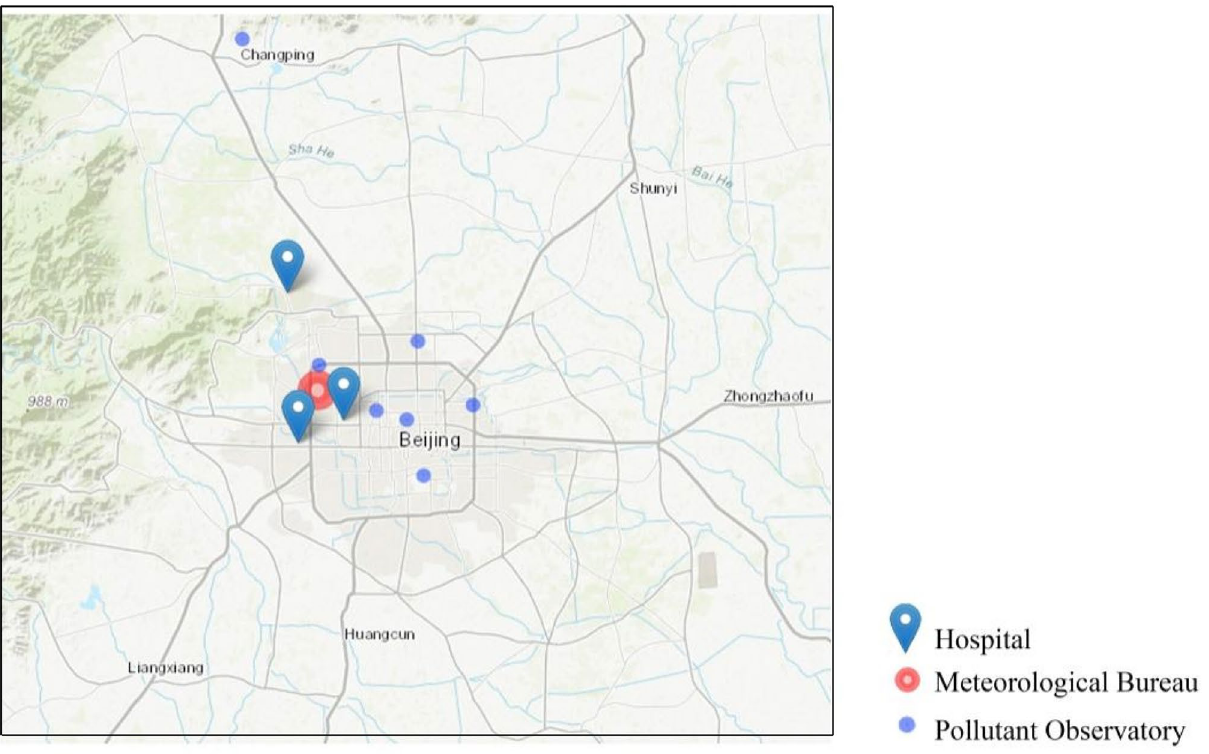
Figure 1. Locations of the three hospitals, the local Meteorological Bureau, and the seven pollutant observatories in the study area (R version 3.6.2 (2019-12-12) https:// mirro rs. tuna. tsing hua. edu. cn/ CRAN/ bin/ windo ws/ base/ old/3.